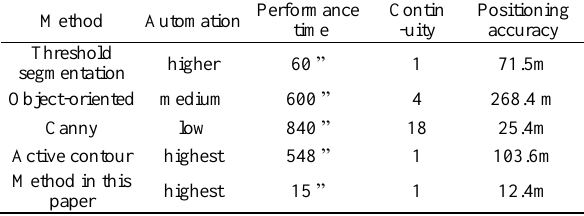
Tabel 2. Evaluation of the extraction efficiency and extraction quality of waterlines.